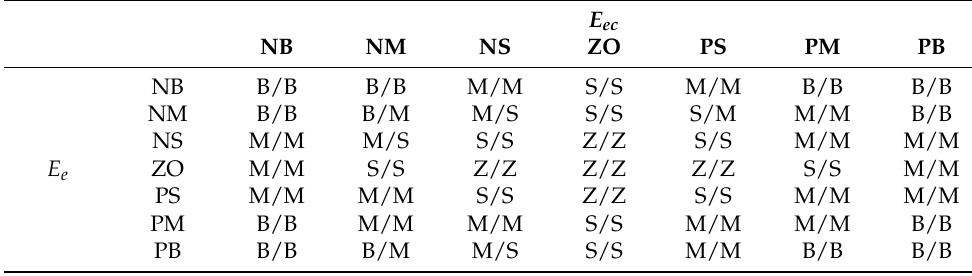
Table 3. Fuzzy control rules table of α e , α ec .